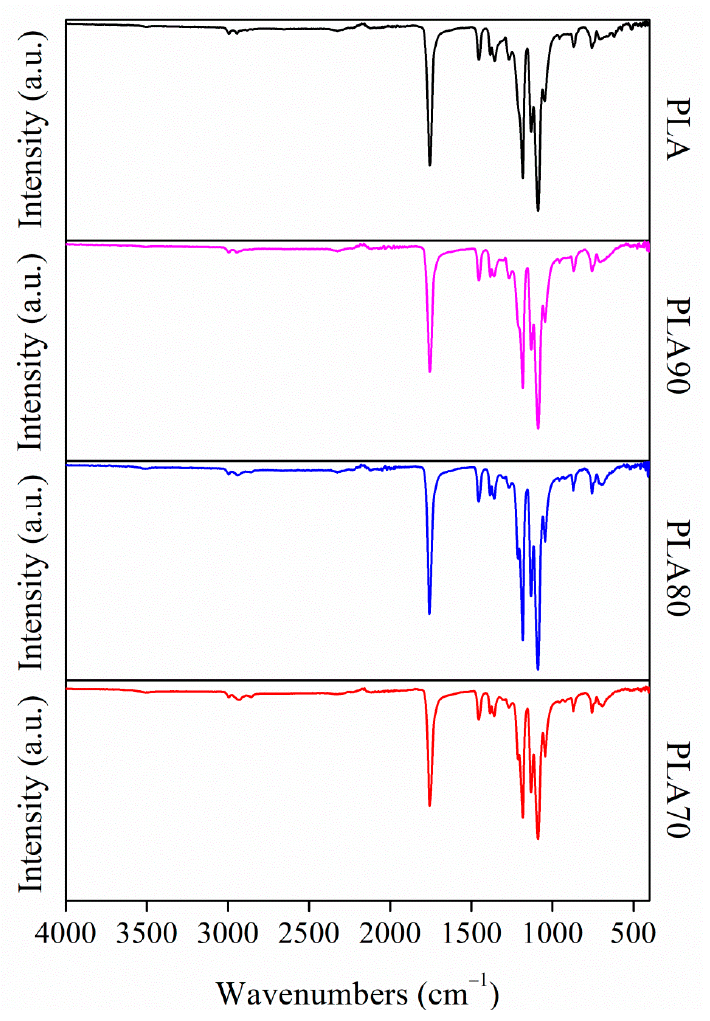
Figure 4. FTIR spectra in the 4000–400 cm − 1 range for PLA and PLA:OLA electrospun samples.